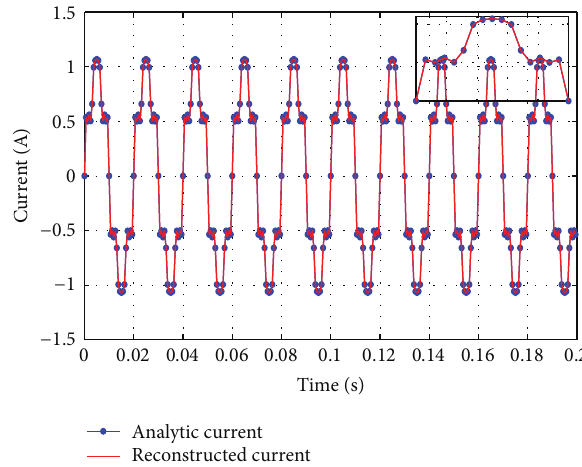
Figure 5: The analytic and reconstructed currents of a nonlinear load. The inset zooms in on a half period of the drawn current in order to show the accuracy of reconstruction.